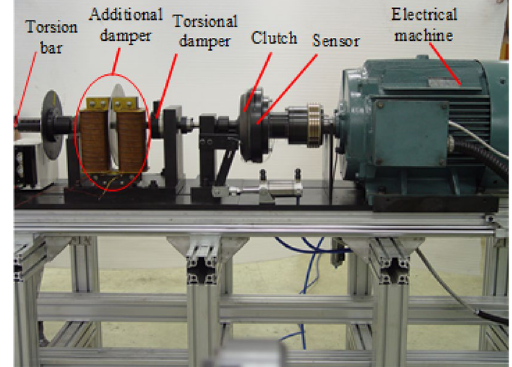
Figure 7 Actual diagram of judder test